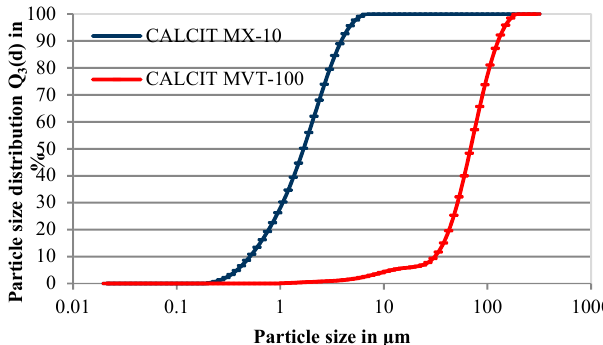
Figure 2. Cumulative size distribution functions of the used fine and ultra-fine particulate materials (measured by Malvern Mastersizer 2000).